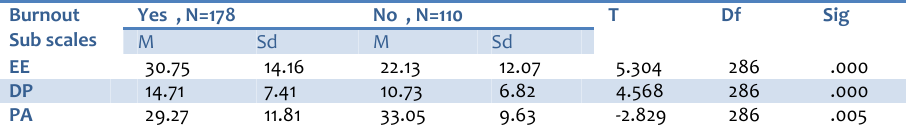
Table 7: Results of t-test on mean difference of burnout based on workload of respondents Yes , N=178